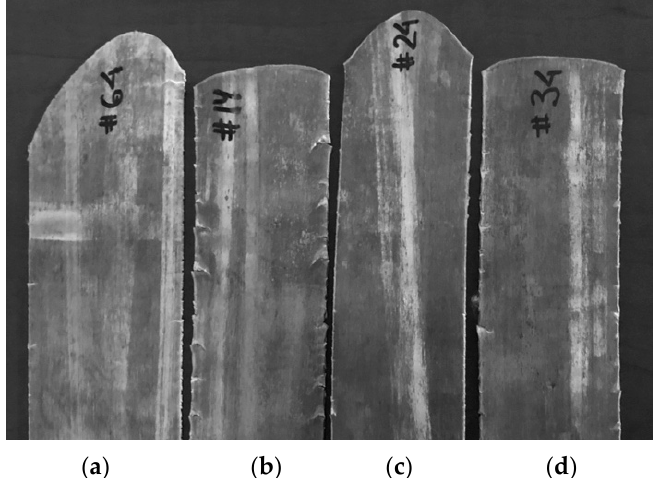
Figure 6. Edge cracks in AA5083 after rolling reduction of 93.75%: ( a ) as-received material; ( b ) as-received material + four (D) sc-ECAE passes; ( c ) solution-treated material + four (D) sc-ECAE passes; and ( d ) over-aged material + four (D) sc-ECAE passes.